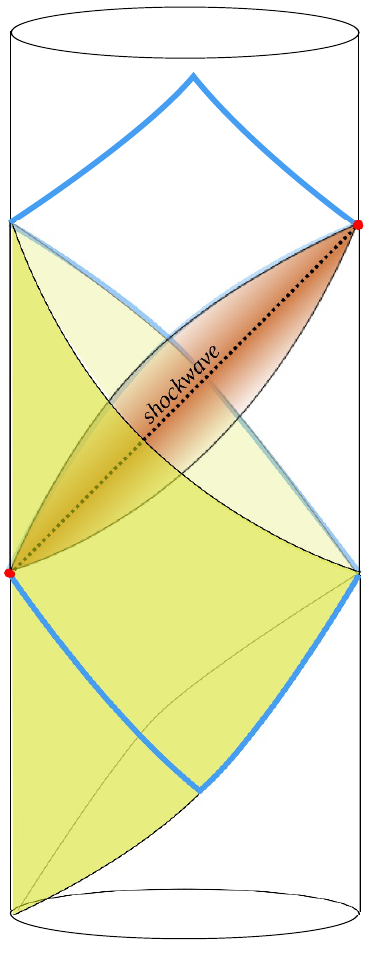
Figure 3 . Shockwave in global AdS, where the boundary is the Lorentzian cylinder. The dashed line is the source, which hits the boundary at the red dots. This source creates a shockwave on the shaded null surface. In the shaded-yellow Poincare patch, the solution is the spherical shockwave. In the shifted Poincare patch, shown as a thick blue outline, the solution is the planar shockwave. The yellow and blue patches in this (cid:12)gure correspond to the same color-coding as the other